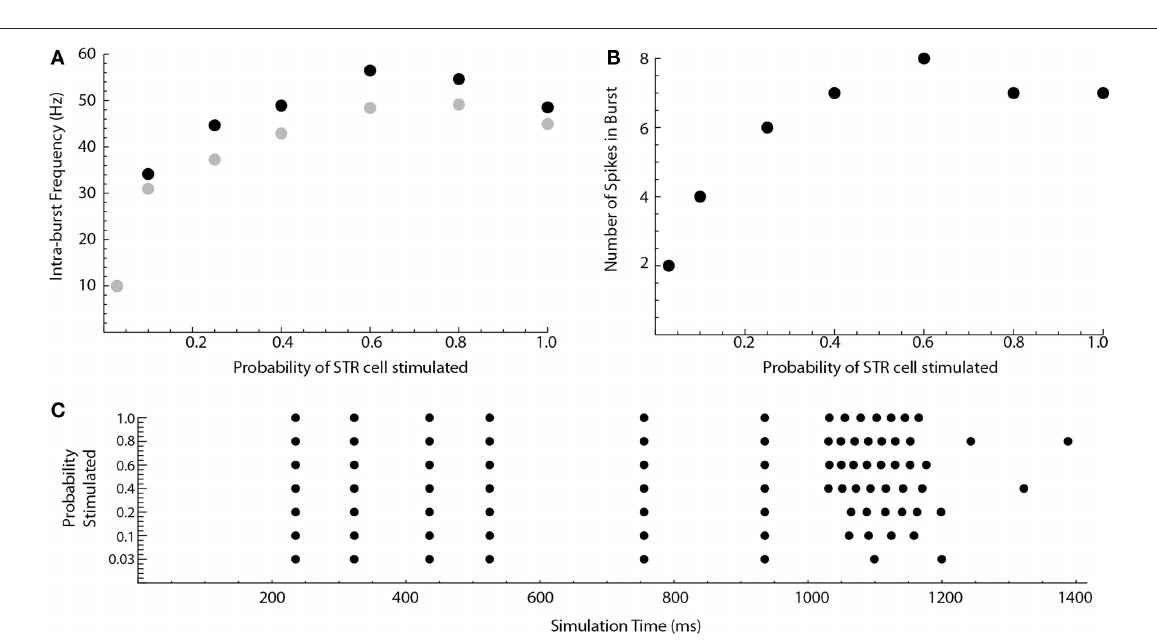
FiGure 5 | Weak striatal stimulation can cause disinhibition bursts. The probability that a striatal cell will be stimulated at t = 1000 ms in the reduced Humphries model is varied. (A) Shows the intra-burst firing frequency of the disinhibition burst (max. black, mean gray). (B) Shows the number of spikes in the burst. A raster plot of the results is shown in (C)